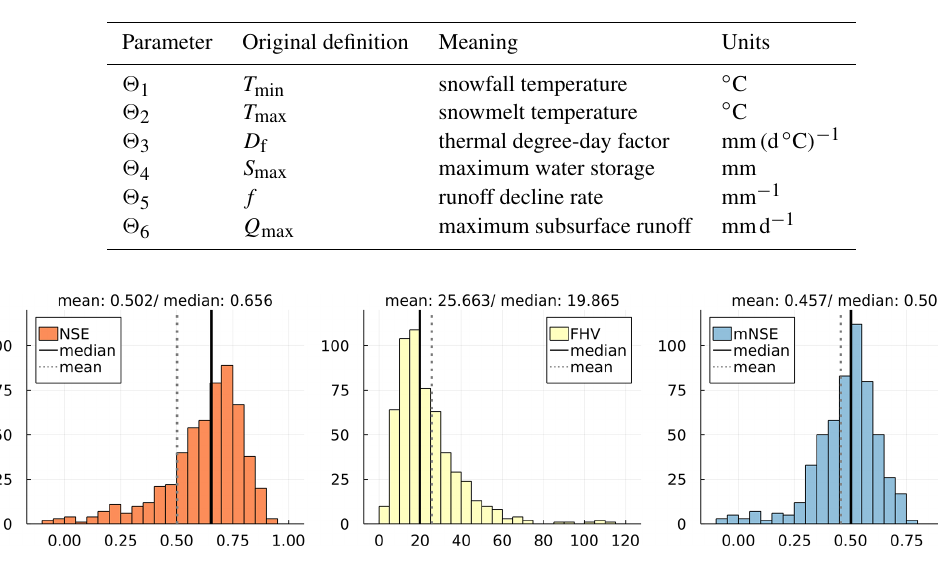
Table A1. EXP-hydro parameter definitions, meaning and units (cf. Patil and Stieglitz, 2014).